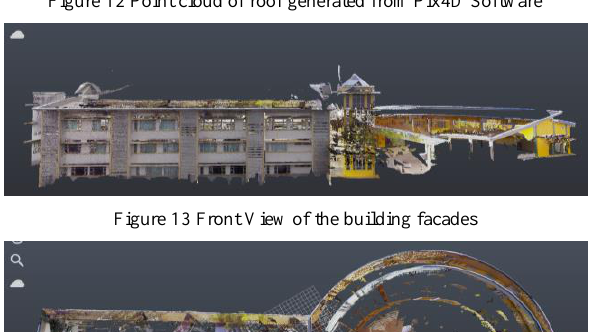
Figure 12 Point cloud of roof generated from Pix4D Software